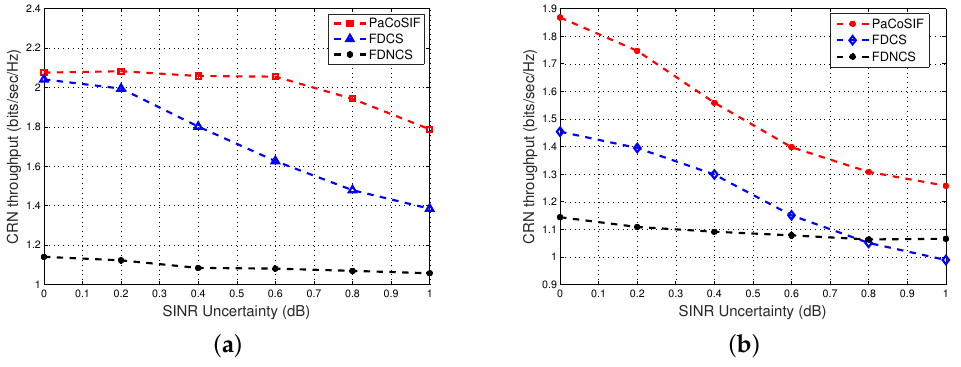
Figure 12. The impact of noise uncertainty upon the CRN throughput. ( a ) ∆ ρ = 4 dB; ( b ) ∆ ρ = − 4